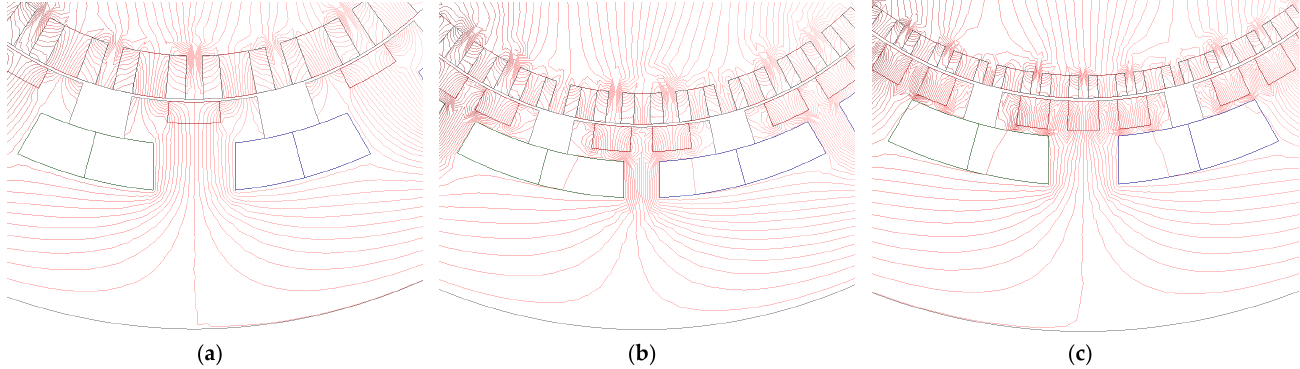
Figure 16. Flux line distributions of 12S1Pa STDPM machines with a different split tooth number at open-circuit condition. ( a ) 2 split teeth; ( b ) 3 split teeth; ( c ) 4 split teeth.